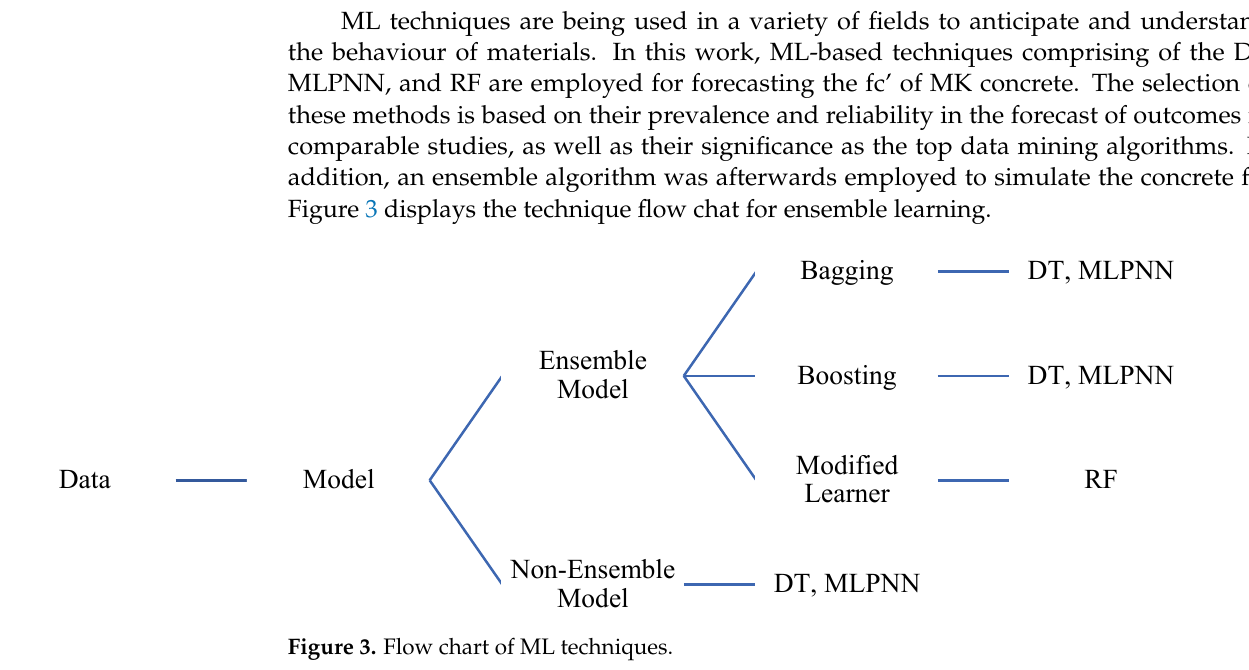
Figure 3. Flow chart of ML techniques .